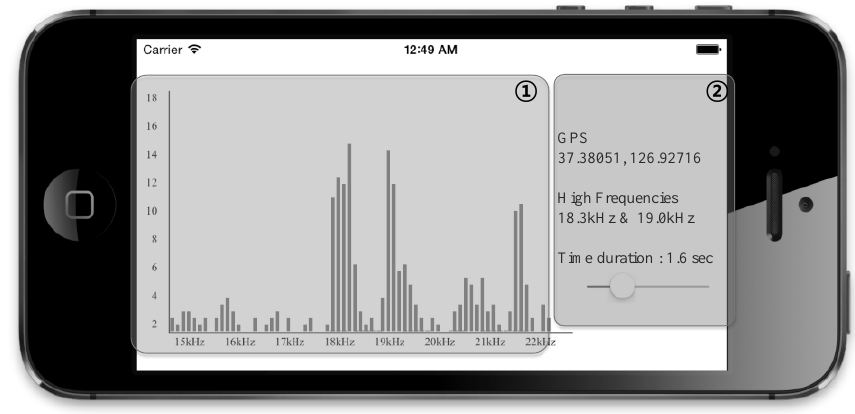
Fig. 3. Screen composition of the proposed application for assigning sequence numbers to customers